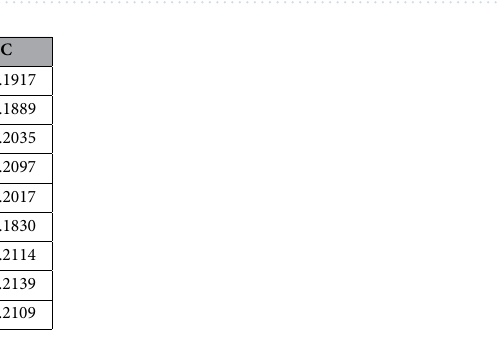
Figure 2. Protein–protein interaction network ( A ). The targets were obtained after the initial screening ( B ). The core targets were obtained after the final screening ( C ).